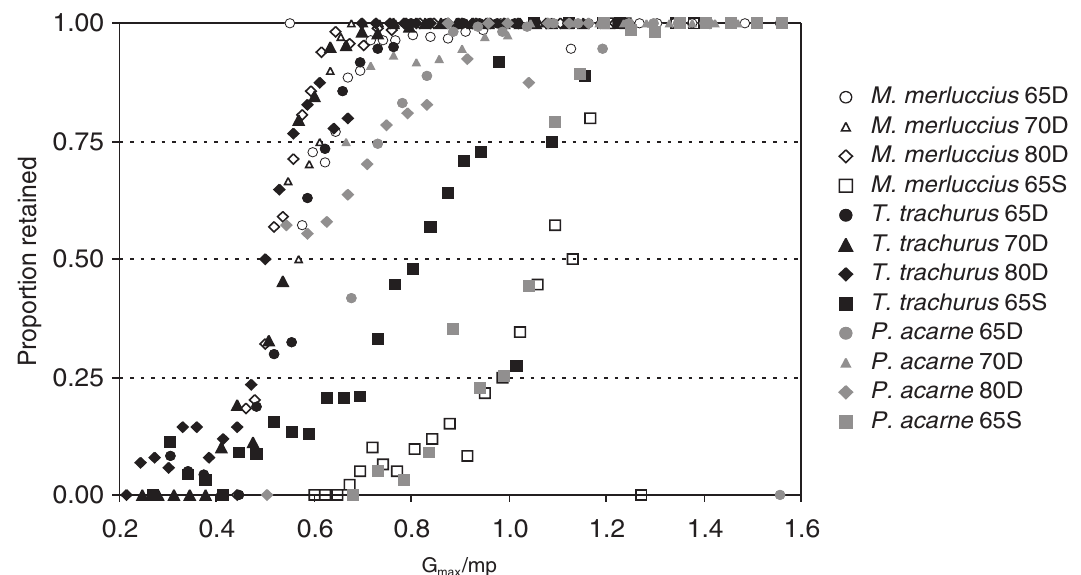
Fig. 10. – Observed retention values for the three species in all cod ends as a function of G